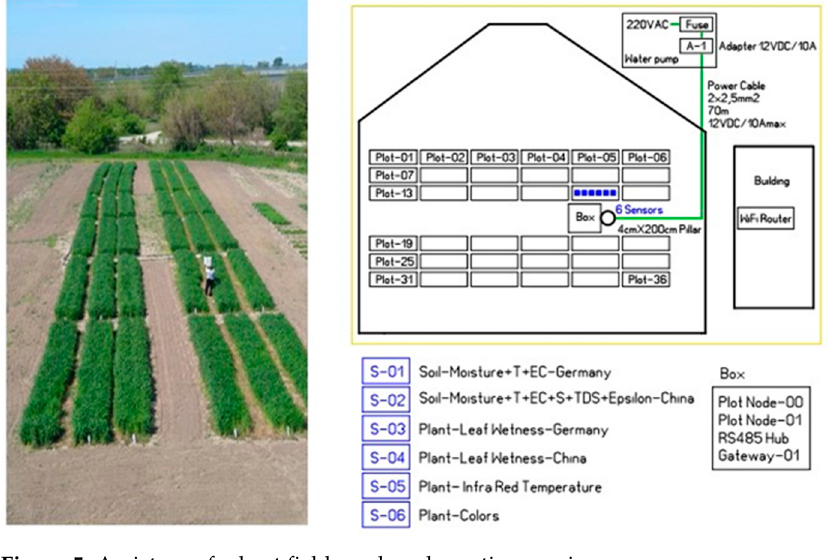
Figure 5. A picture of wheat fields and a schematic overview.